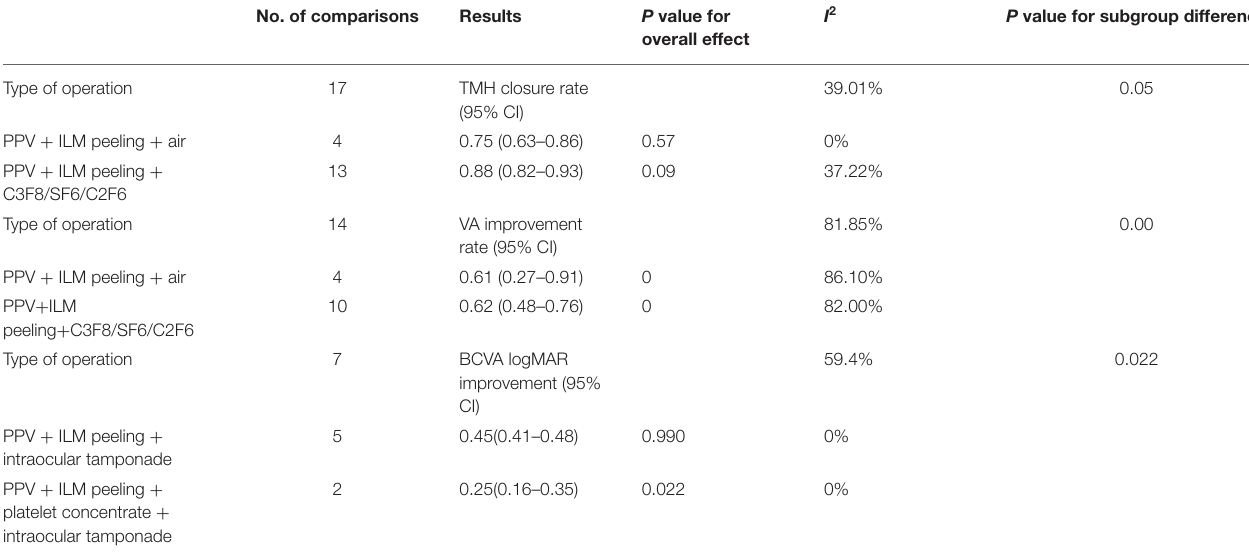
TABLE 3 | Subgroup analysis for